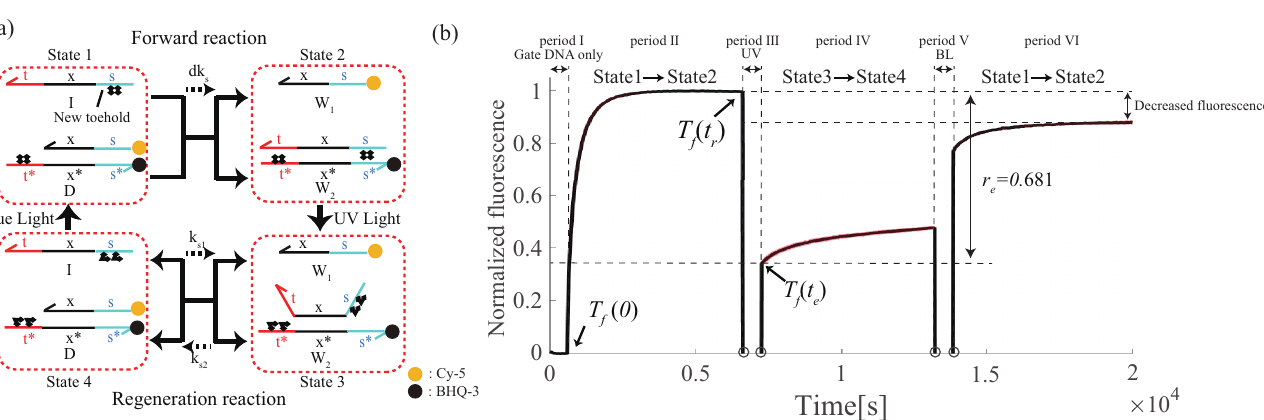
Figure 9. ( a ) Azo-degradation used in the experiment; and ( b ) the results of the renewable experiment of the azo-degradation circuit. This result is the average of three times with 500 nM input, 1000 nM gate, and 37.5 ◦ C. Colored areas represent the standard